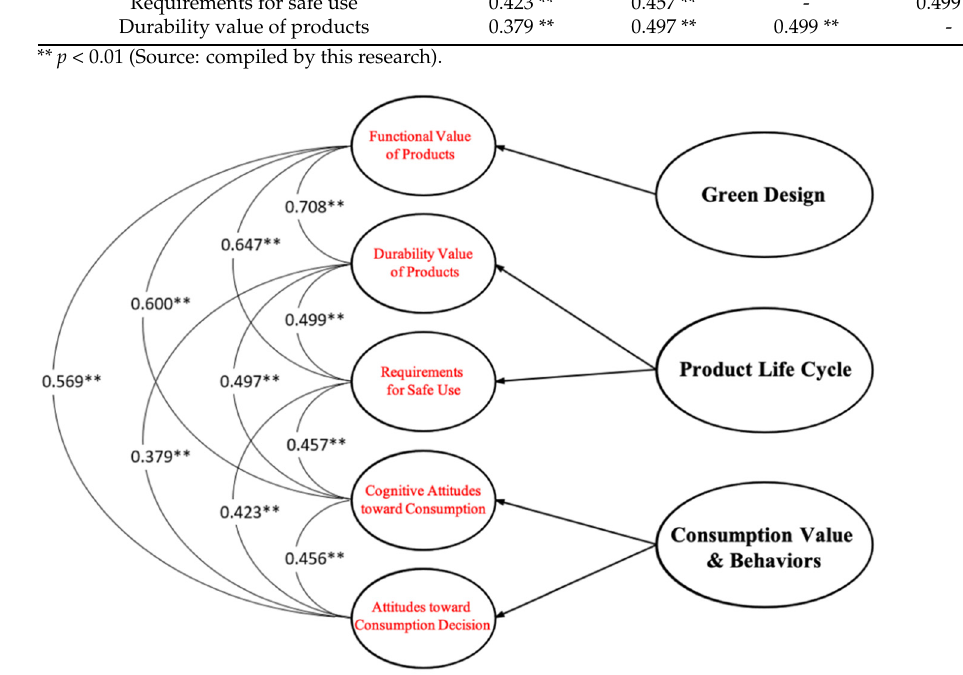
Figure 4. Correlation between green design and product life cycle and consumption value and behaviors (Data: compiled by this research, ** p < 0.01).